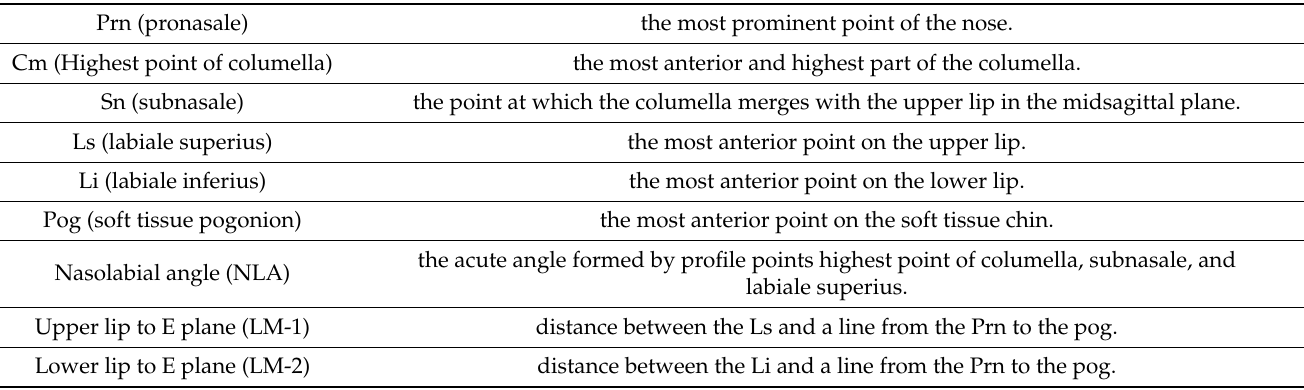
Table 1. Soft tissue landmarks, angular, and linear measurements. Prn (pronasale) the most prominent point of the nose. Cm (Highest point of columella) the most anterior and highest part of the columella. Sn (subnasale) the point at which the columella merges with the upper lip in the midsagittal plane. Ls (labiale superius) the most anterior point on the upper lip. Li (labiale inferius) the most anterior point on the lower lip. Pog (soft tissue pogonion) the most anterior point on the soft tissue chin. the acute angle formed by profile points highest point of columella, subnasale, and Nasolabial angle (NLA) labiale superius. Upper lip to E plane (LM-1) distance between the Ls and a line from the Prn to the pog. Lower lip to E plane (LM-2) distance between the Li and a line from the Prn to the